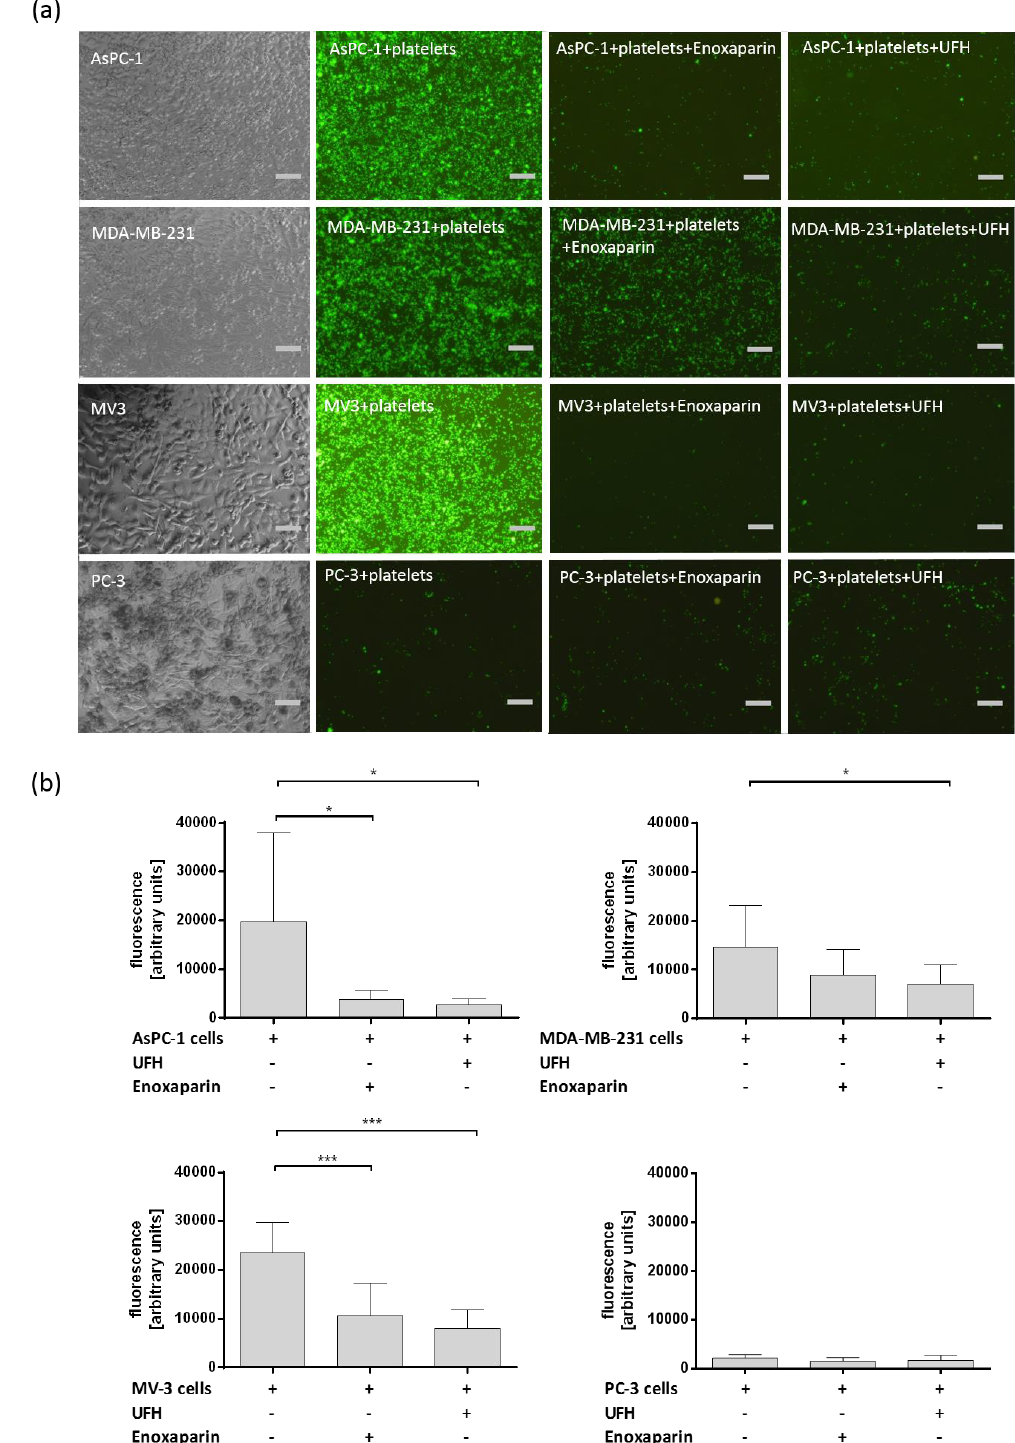
Figure 1. ( a ) Representative pictures of Calcein-AM labeled platelets interacting with confluent layers of AsPC-1, MDA-MB-231, MV3 and PC-3 cells. Prior to interaction platelets were coincubated with 1 IU/mL UFH or 1 IU/mL enoxaparin. Scale bar corresponds to 50 µm. ( b ) Quantification of platelet (Calcein-AM labeled) tumor cell (AsPC-1, MDA-MB-231, MV3 and PC-3) by fluorescent plate reader assay. Data are means of at least n = 3 ( ± SD), asterisks indicate statistical significance: * p ≤ 0.05; *** p ≤